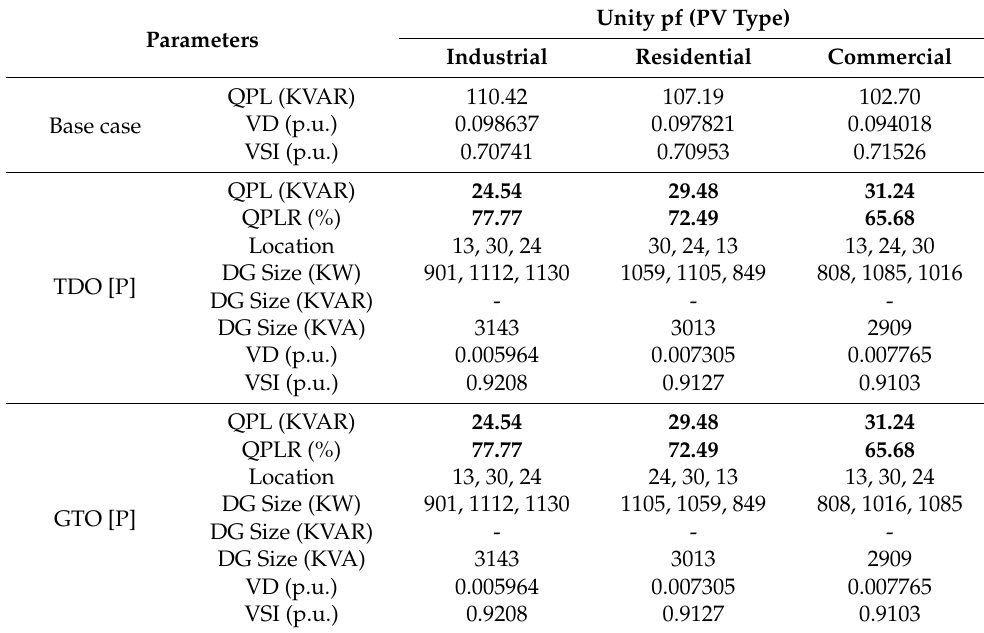
Table A3. Results of OADG for a 33-bus RDN for SOP (QPL minimization) at unity pf (PV type) in a VP load